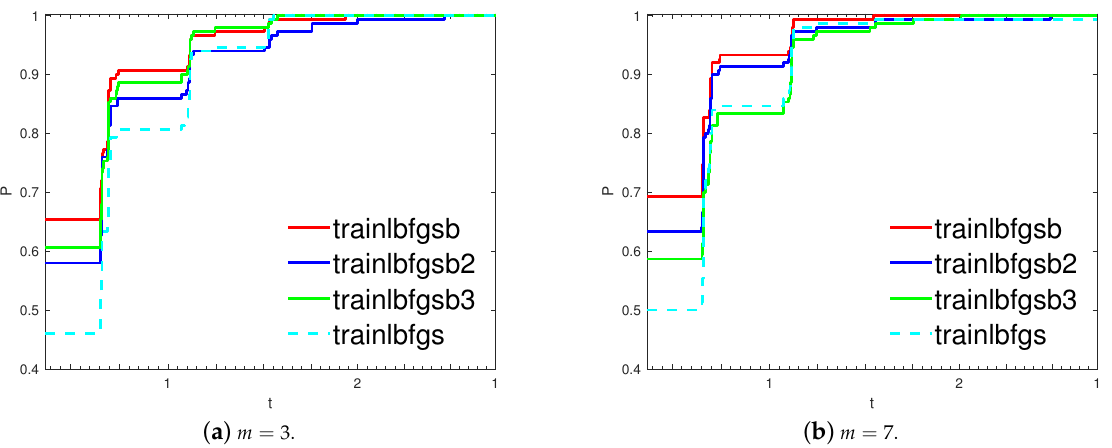
Figure 4. Log 10 scaled performance profiles based on F 1 -score for the Australian credit card classi- fication